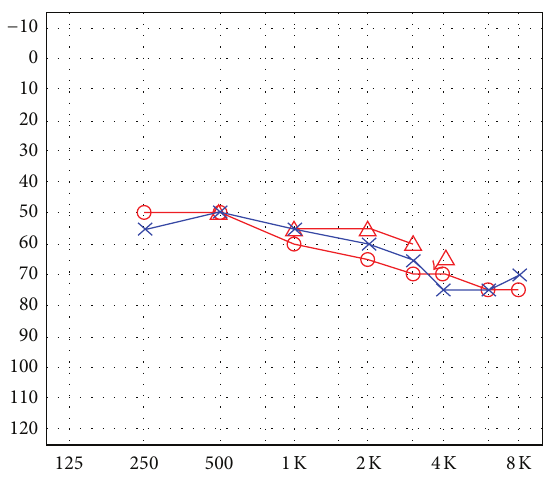
Figure 2: Audiogram showing bilateral moderate sensorineural hearing